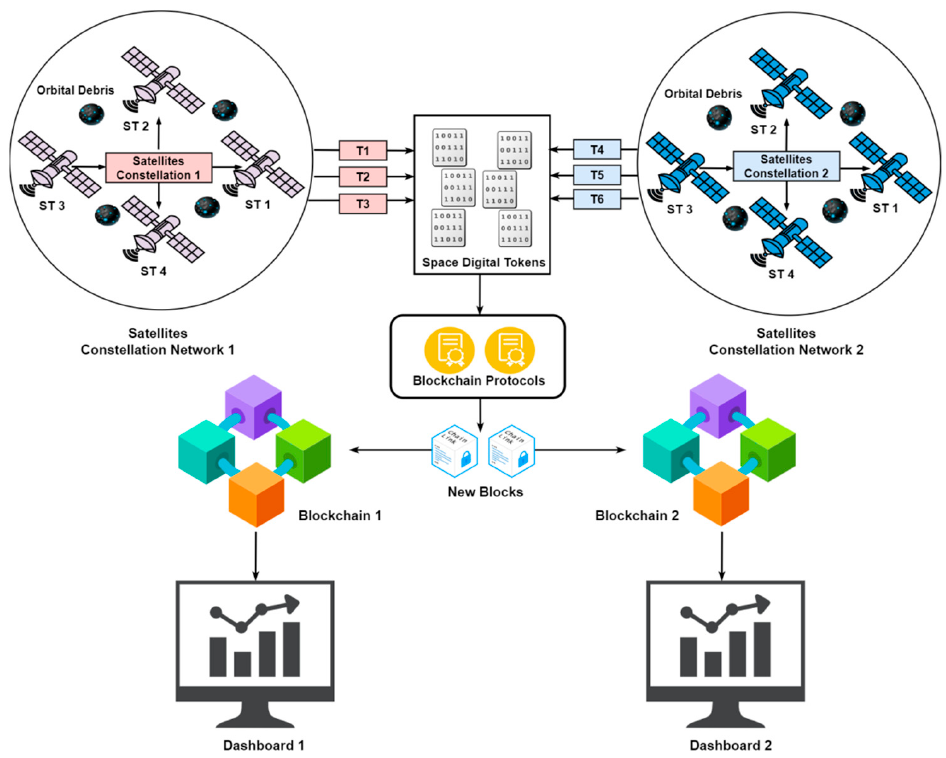
Figure 1. Modeling space digital tokens using Blockchain.